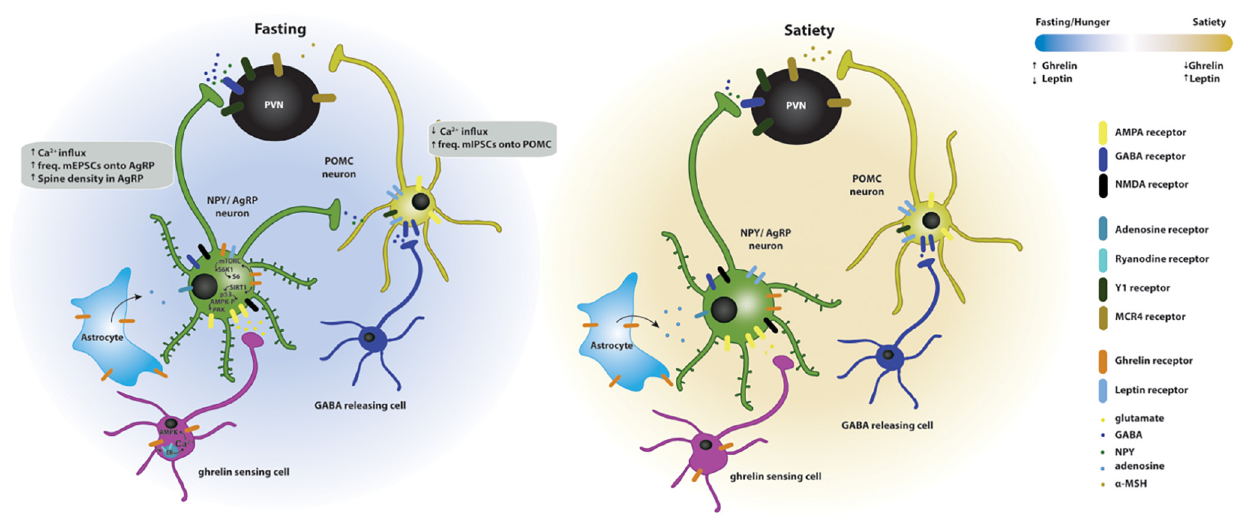
FIGURE 2 | Effects of ghrelin on synaptic plasticity of hypothalamic circuits associated with feeding. Two energy states are represented: fasting/hunger and satiety. In the fasted state, AgRP neuronal activity and dendritic spine density are increased, while POMC neuronal activity is decreased. The AgRP neurons release NPY and GABA and the POMC neurons release POMC, which is subsequently cleaved to produce α -MSH, and targets the melanocortin receptors in the paraventricular nucleus (PVN MCR4) to regulate feeding responses. The effects of fasting on hypothalamic synaptic plasticity can be mediated directly by the activation of the GSH-R1a in AgRP neurons or indirectly by the upstream regulation of AgRP and POMC neurons. Upstream neurons include ghrelin-sensing cells that release glutamate on AgRP neurons through a mechanism dependent on the release of calcium from internal stores and subsequent activation of AMPK, therefore increasing the excitatory synaptic input onto these neurons. Simultaneously, ghrelin leads to the activation of NMDA receptors, of the SIRT1 → p53 → AMPK → PAK and of the mTORC → S6K1 → S6 pathways, which drive state-dependent excitatory synaptic plasticity in AgRP neurons. In parallel, a population of neurons release GABA onto the POMC neurons therefore increasing the inhibitory tone on these neurons. In the fed state, the balance of excitatory versus inhibitory synaptic inputs in the AgRP and POMC neurons is reversed, increasing the anorexigenic melanocortin tone. Additionally, astrocytes express GSH-R1a and its activation promotes the release of adenosine that will bind to the adenosine A1 receptors expressed in the AgRP neurons, thus, decreasing their excitation threshold.